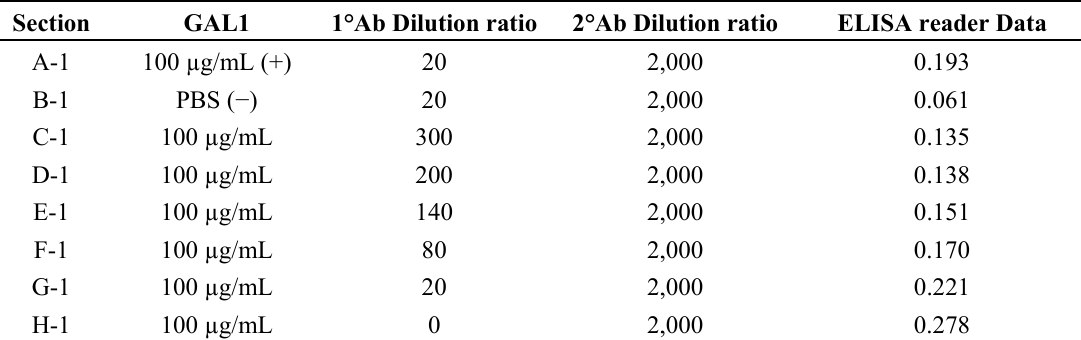
Table 2. Measurement results from ELISA